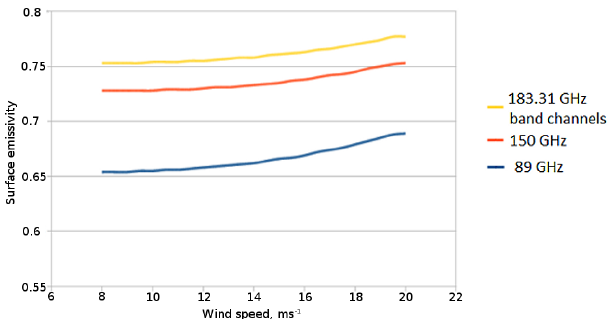
Figure 1. Ocean surface emissivities’ dependence on wind speed.